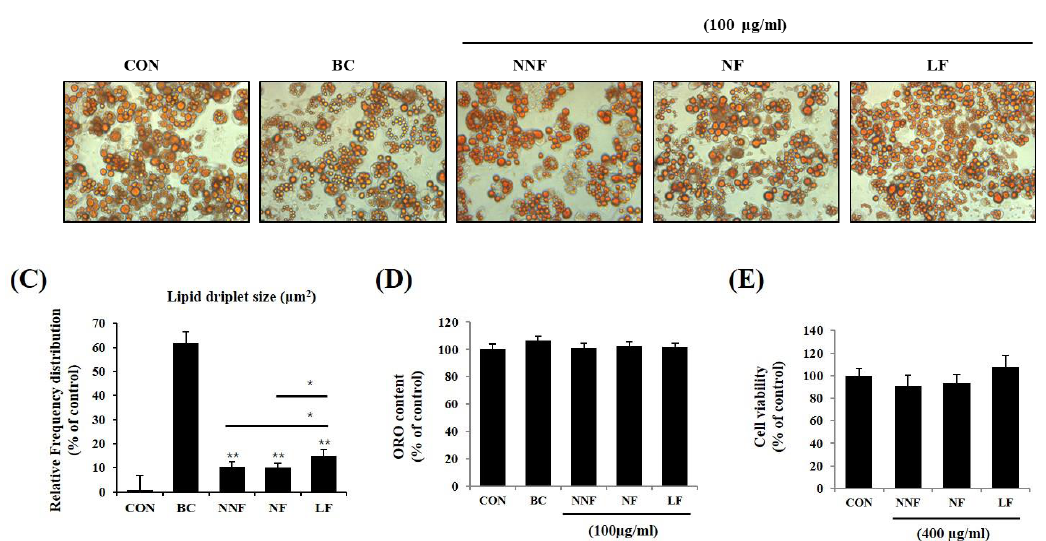
Figure 5. Effects of different fermented PSPs on the differentiation of 3T3-L1 preadipocyte: ( A – C ) The adipocytes were treated with NNF, NF, or LF at 100 µg/mL during the entire period of differentiation. BC, treating the 3T3-L1 adipocytes with a browning cocktail. The representative images of the cells ( A ) and ORO-stained-cells ( B ) in each indicated group. ( C ) Intracellular lipid droplets size was measured using ImageJ software. ( D ) The ORO staining in the cells was dissolved and measured. ( E ) The preadipocytes were treated with NNF, NF, or LF at 400 µg/mL or not treated (CON). After treatment for 24 h, cell viability was determined using the MTT assay. The bars represent the means ± SD of three independent experiments. * p < 0.05 and ** p < 0.01, comparison to the control.